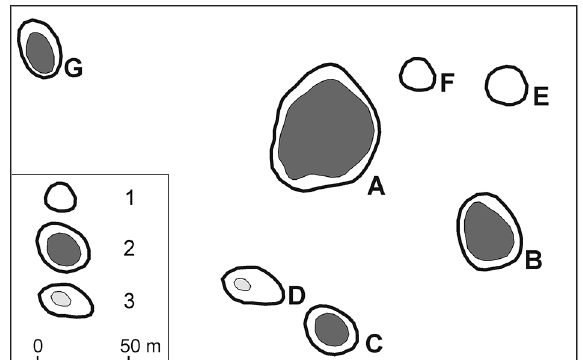
Fig. 9. Spatial distribution of main impact craters in Morasko